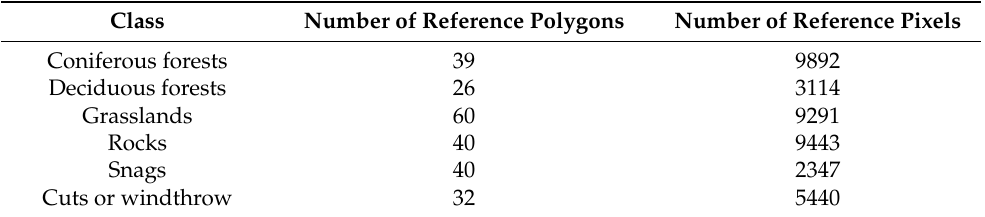
Table 1. Number of reference polygons and pixels by a class for the 2015 Sentinel-2 image classification.